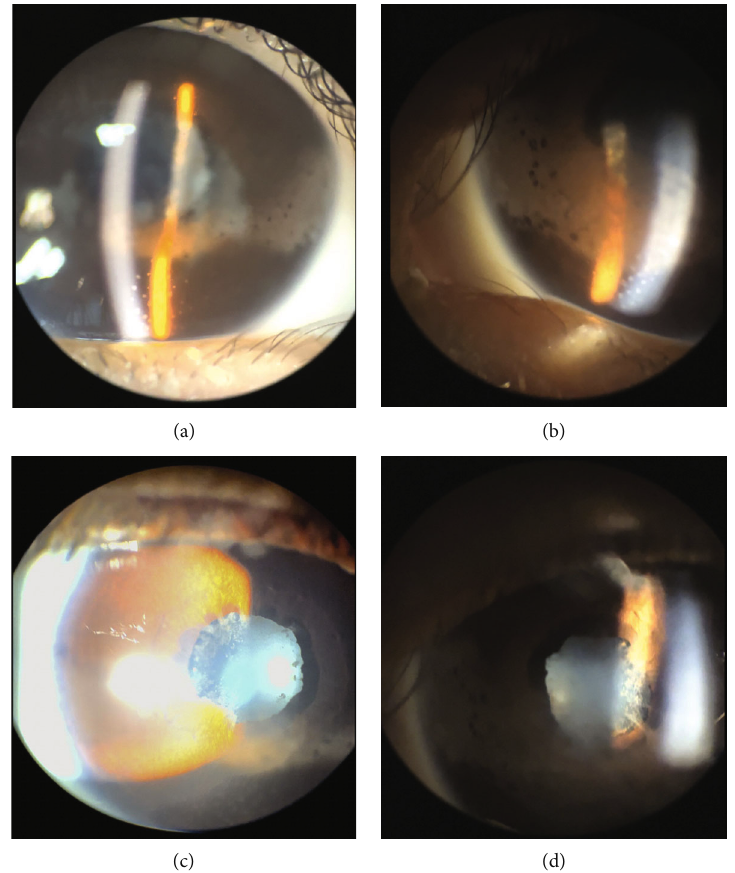
Figure 1: Color photographs (obtained upon presentation) showing granulomatous (mutton-fat) KPs, band keratopathies (a and b), and multiple posterior synechiae (c and d); OD and OS, respectively.